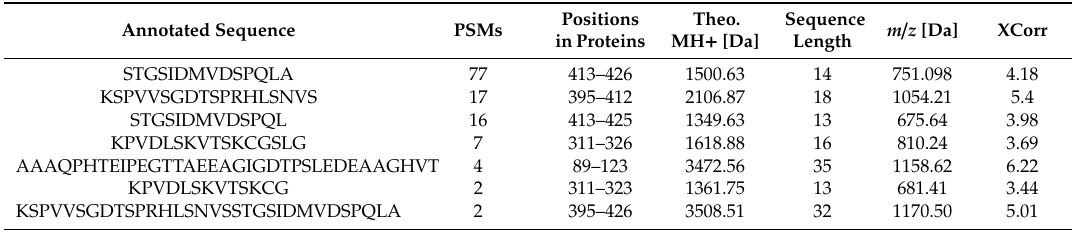
Table 2. Selected human phosphorylated tau-441 calpain-mediated proteolytic peptides from purified protein digestion identified by nLC-MS / MS.